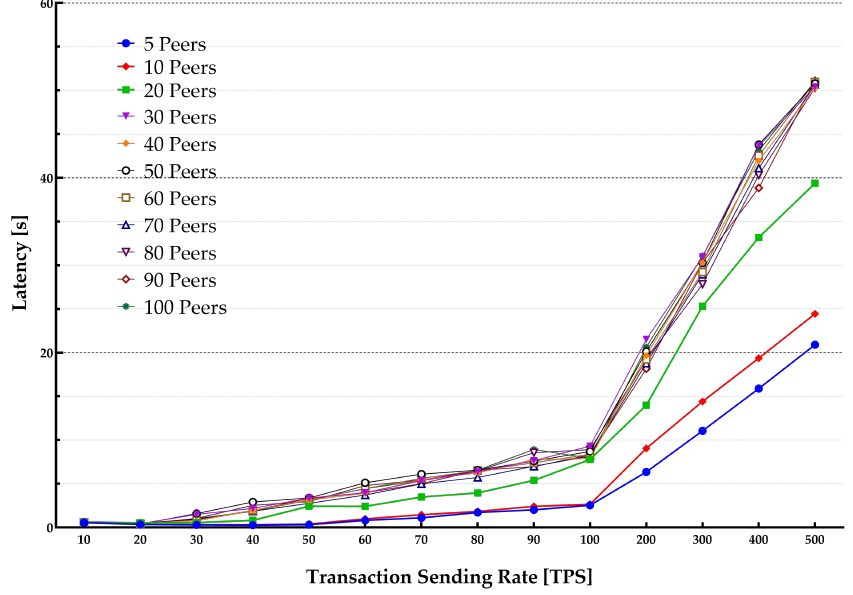
Figure 8. Transactions sending rate vs latency for multiple host